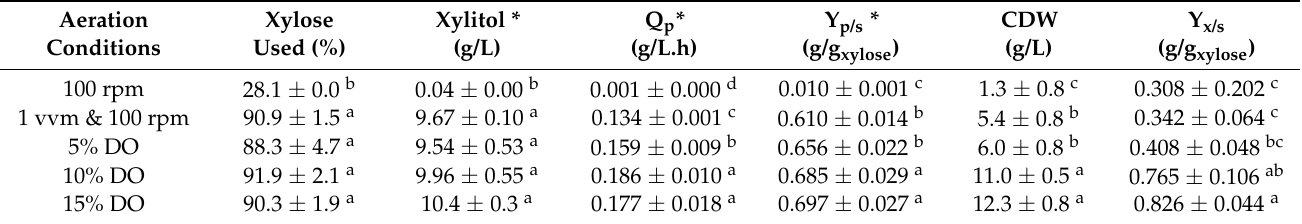
Table 2. Parameters from xylitol fermentation by C. guilliermondii using vinasse supplement by 1 g/L of yeast extract cultivated at different dissolved oxygen levels for 72